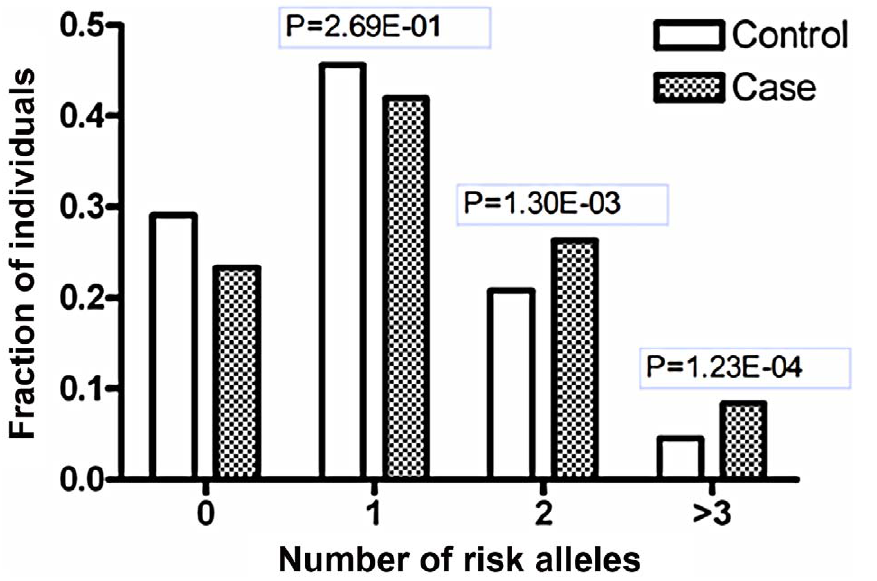
Figure 5. Joint effects of the risk-associated alleles of ETS1 and miR-146a . Shanghai individuals (703 patients and 983 controls) with known genotypes for both variants (rs1128334 in ETS1 and rs57095329 in miR-146a ) were analyzed for the distributions of the risk-associated alleles for SLE; fraction of each group with different numbers of risk alleles was shown. The P values were calculated with the x 2 test for the differences in the allele counts between the patients and the controls in the groups with two or more risk-associated alleles, compared with the groups with zero risk- associated alleles.